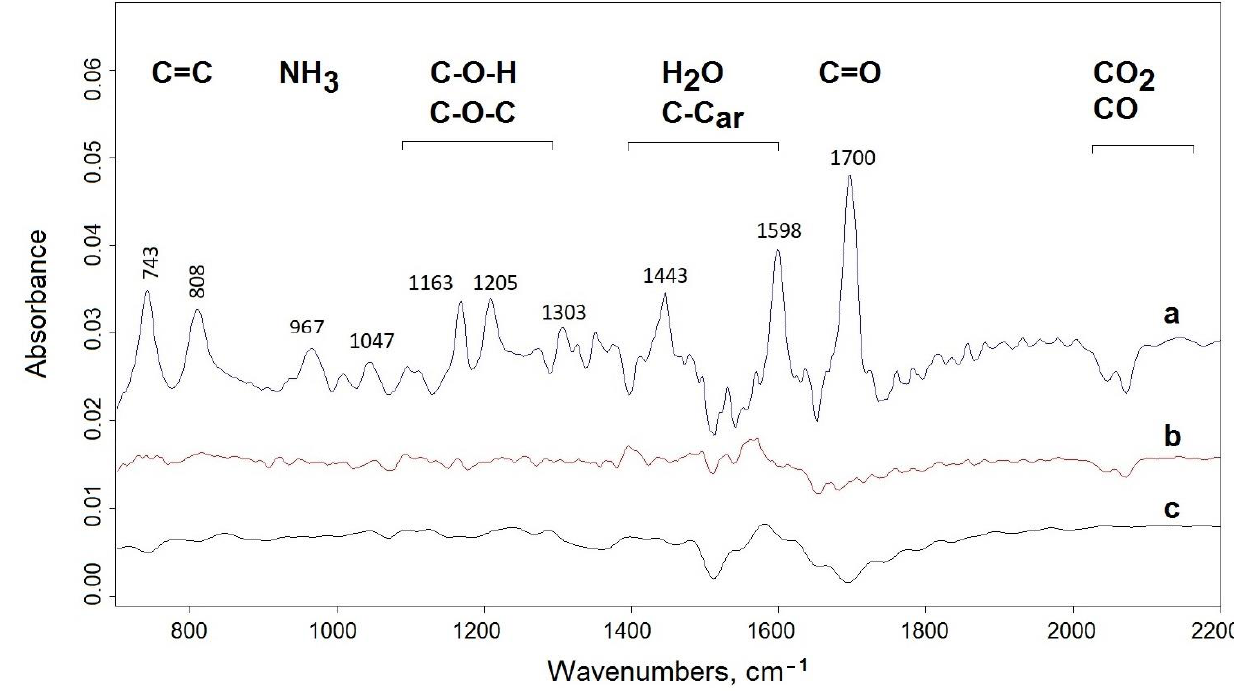
Figure 3. FTIR spectra of evolved gases from BIm ( a ), BOx ( b ), and BTh ( c ) at 500 °C. At the top, the main bands are assigned to the respective groups.